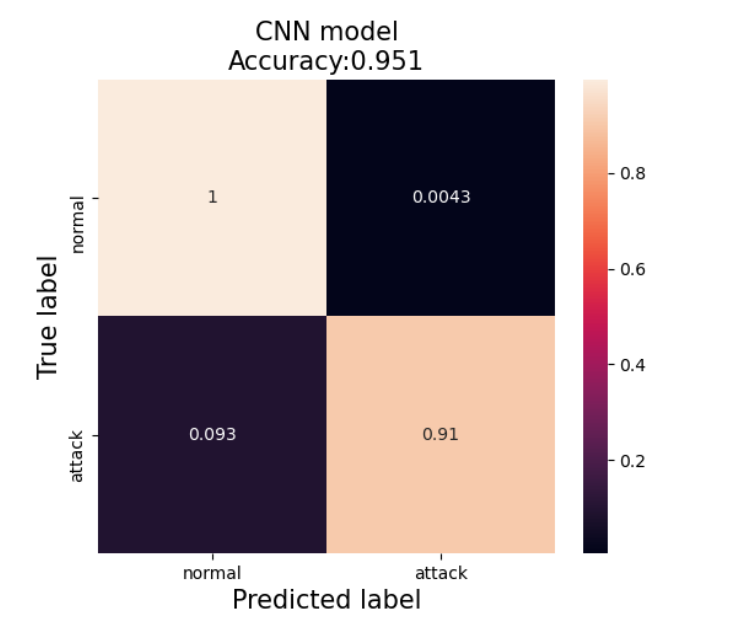
Figure 5. Confusion matrix of CNN model on balanced KDD_cup99 dataset.